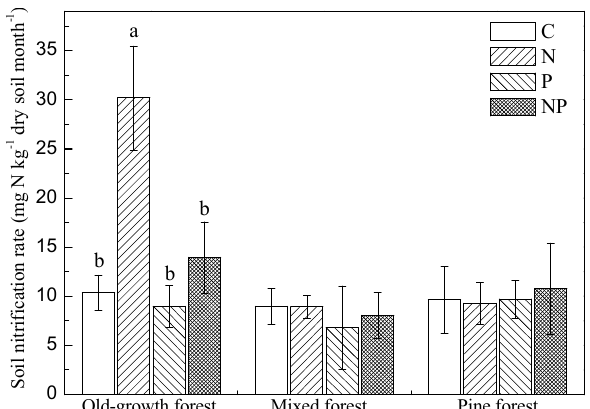
Figure 6. Effects of N and P addition on soil nitrification rate in the three study forests in August 2008. Error bars represent standard er- rors ( n = 5). Different lowercase letters within each forest represent significant differences among treatments, as determined by one-way ANOVA ( P